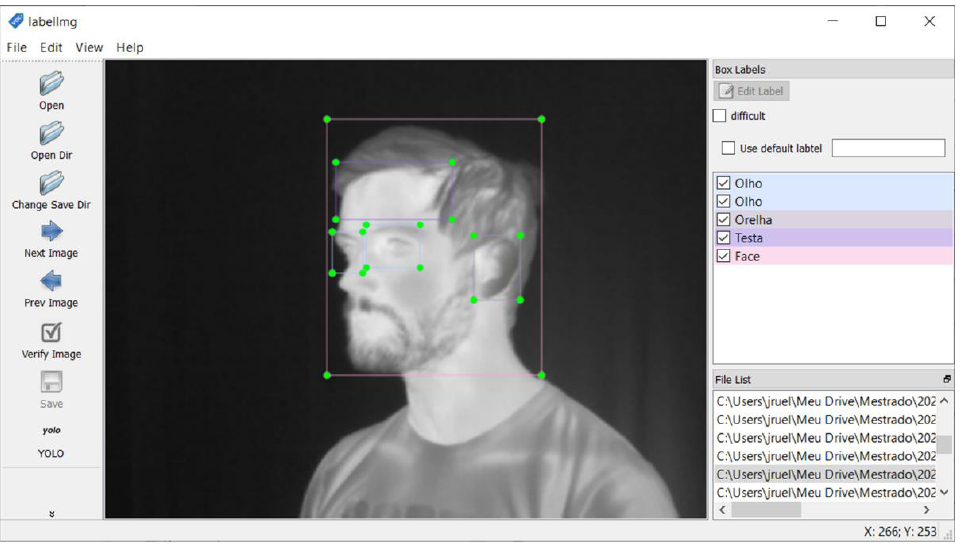
Figure 6. LabelImg software graphical interface.